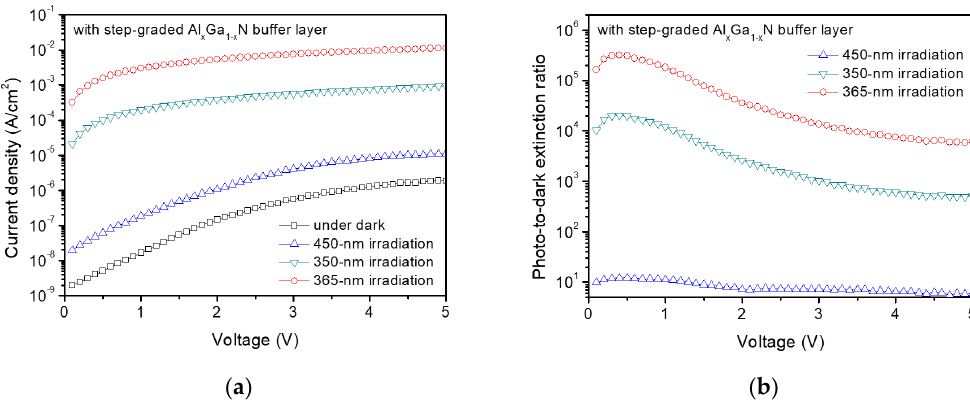
Figure 3. Electrical characteristics of GaN MSM UV photodetector with the step-graded Al x Ga 1 − x N buffer layer. ( a ) Current-voltage (I-V) characteristics and ( b ) photo-to-dark extinction ratios of the GaN photodetector at dark condition and under UV illumination with different wavelengths.